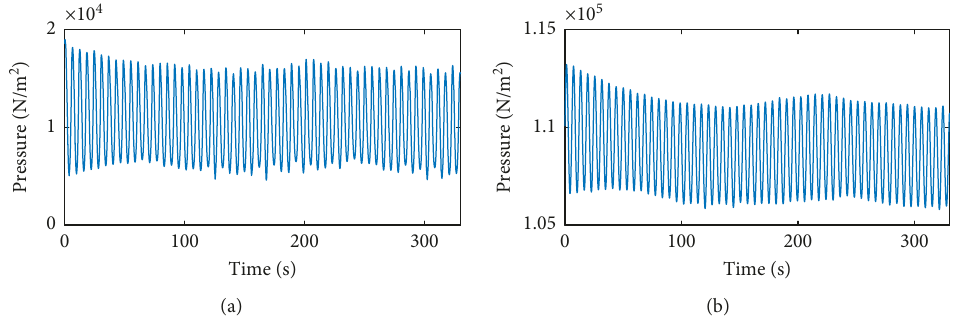
2.2m. (b) Wave (cid:31) −